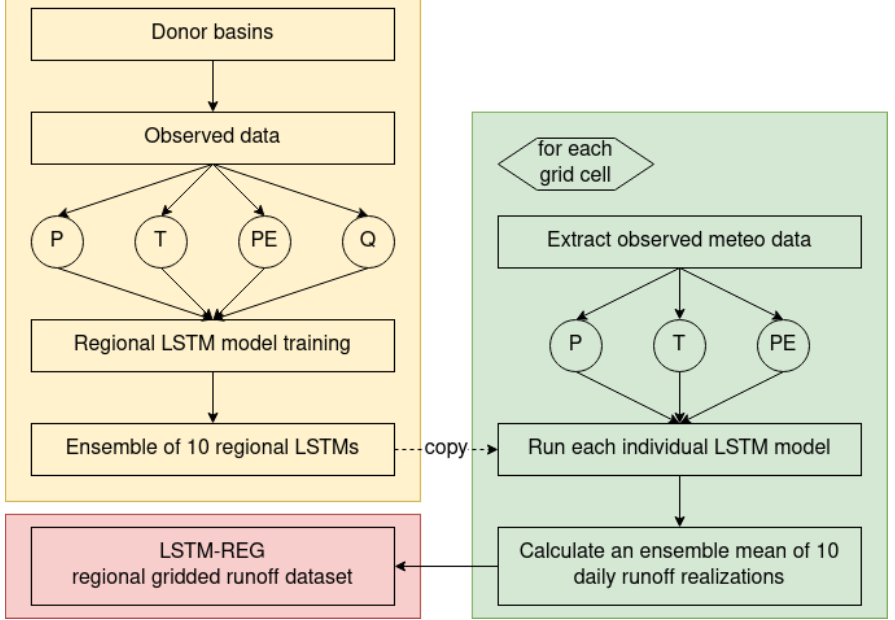
Figure 5. Schematic representation of the proposed workflow for the development of the LSTM-REG